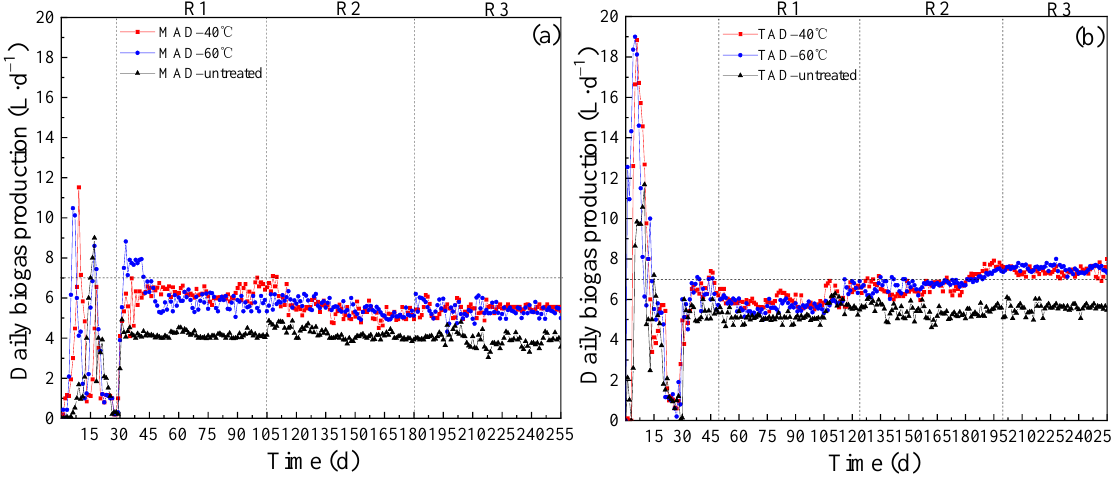
Figure 1. ( a , b ). Daily biogas production of CS under different pretreatment and AD conditions. ( a ): different pretreatment conditions for MAD; ( b ): different pretreatment conditions for